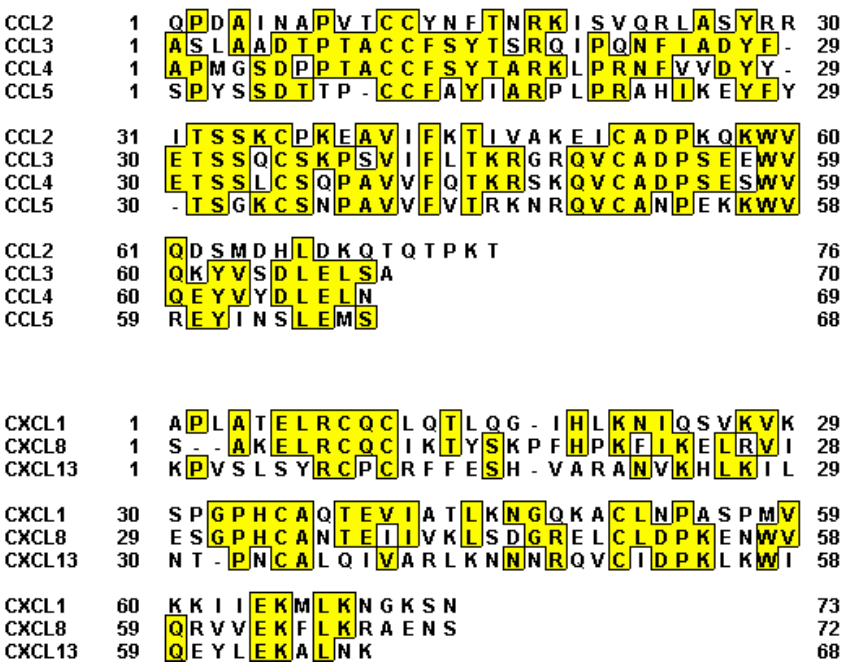
FIGURE 1. Primary structure of selected members of the CC and CXC chemokine superfamily. Chemokines have been grouped into the CXC, CX3C, CC, and C branches of the family based on the position of the conserved four cysteine motif. Conserved amino acids are shown in